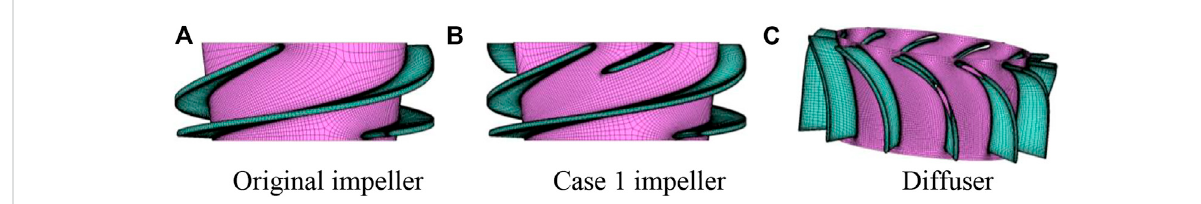
FIGURE 3 Complex impeller model.